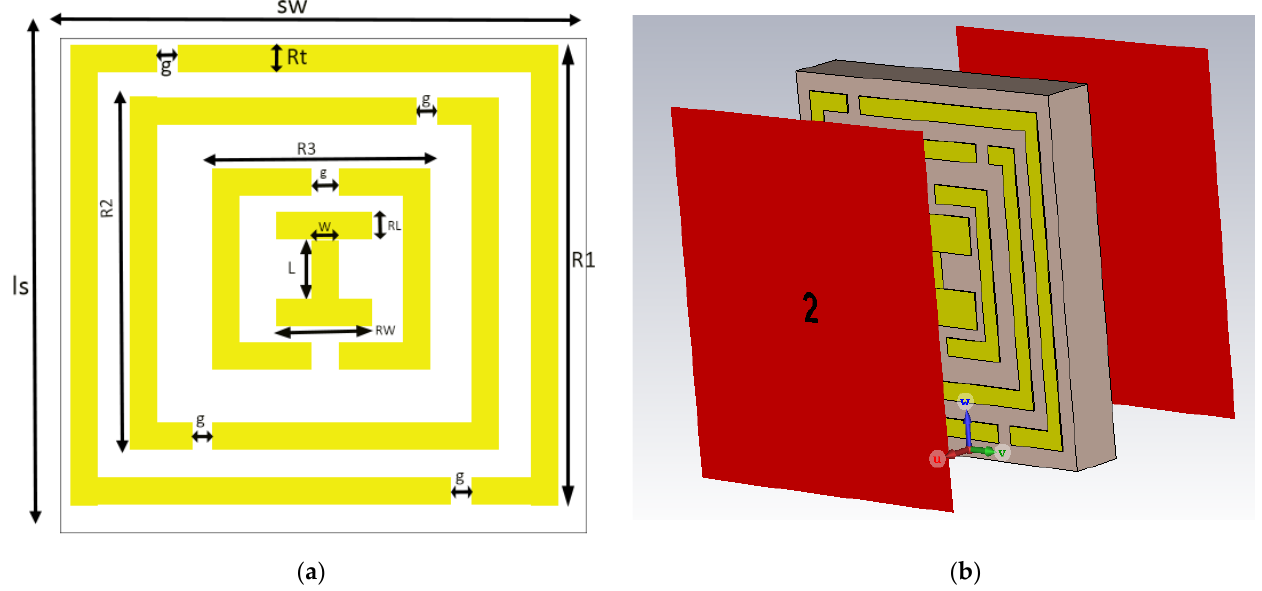
Table 1. Parameter of the ISMeTM unit cell.